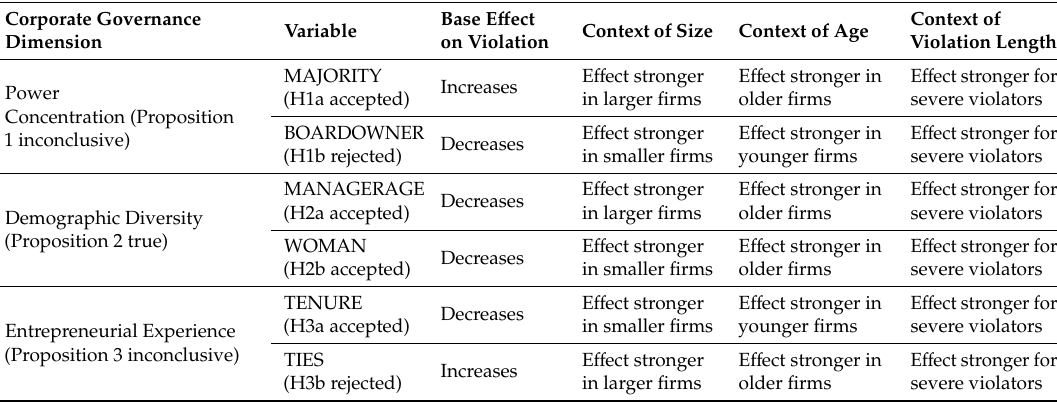
Table 6. Summary of the associations found in this